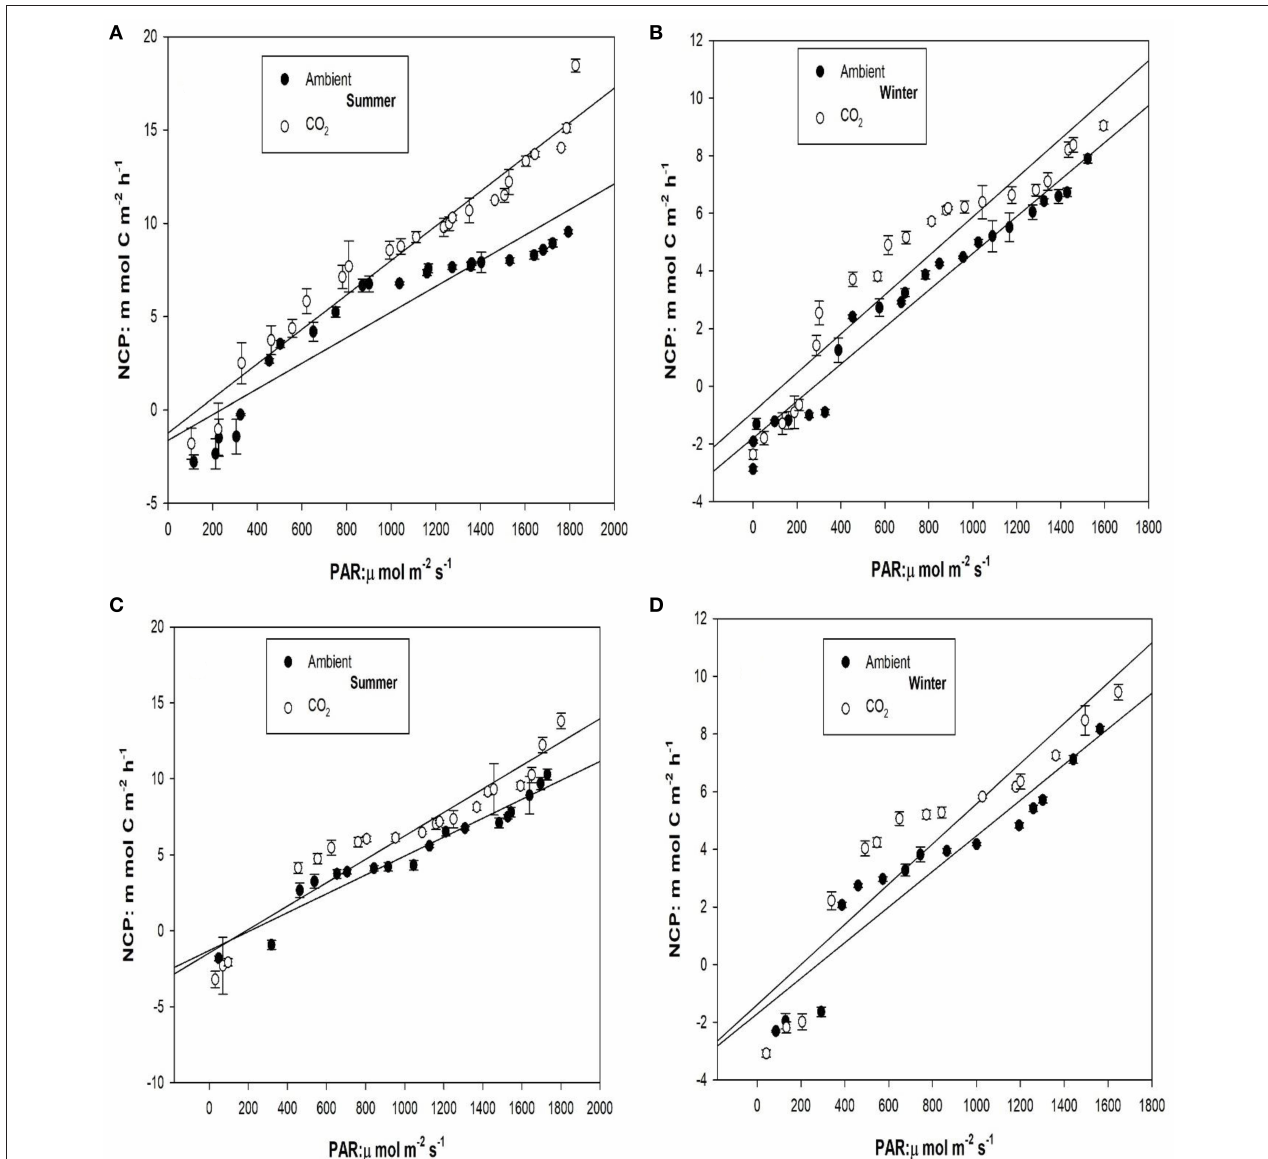
FIGURE 3 | Response of net community production (NCP) to irradiance (PAR) under ambient and CO 2 enriched conditions in summer and winter for Z. noltei , (A,B) and sediments (C,D) . Error bars represent standard